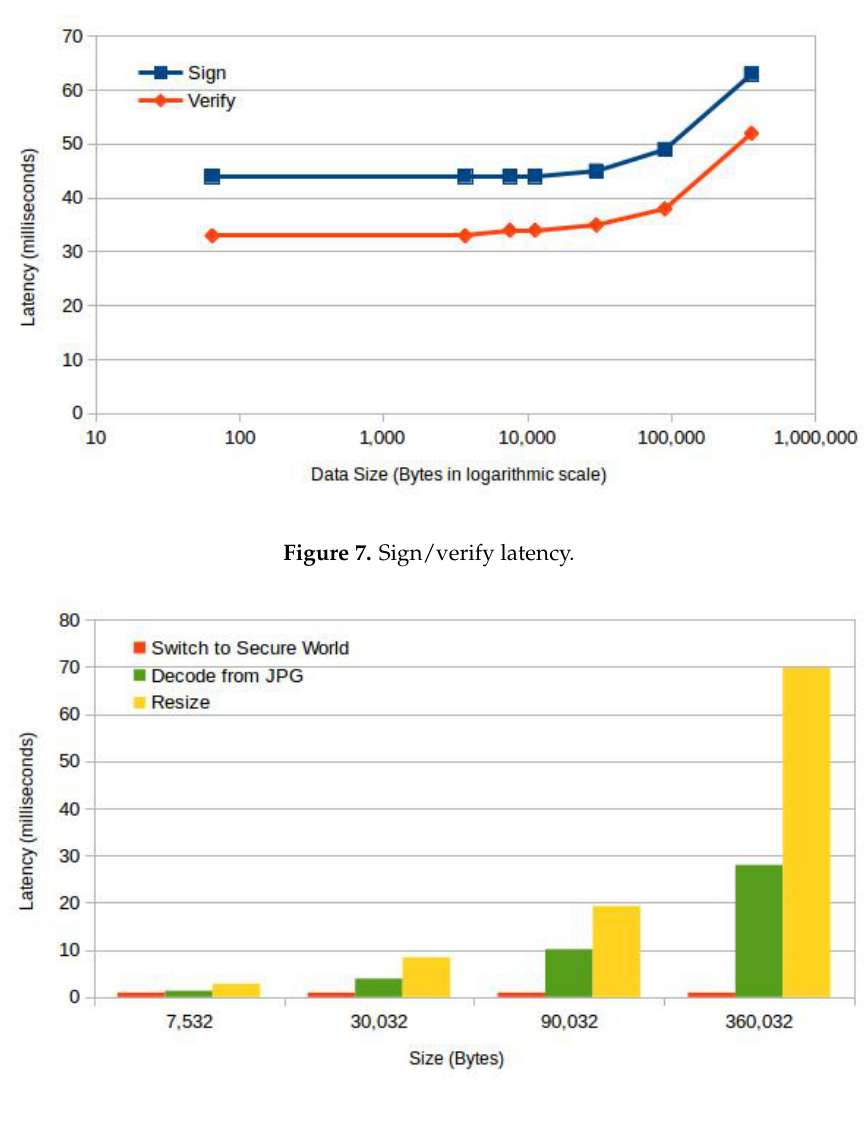
Figure 8. Operations vs. context